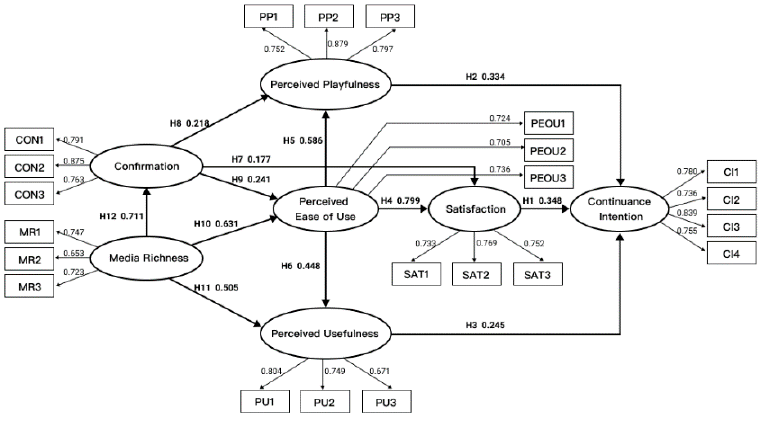
Figure 4. The influence between variables in the structural model. Table 5. Hypothesis test